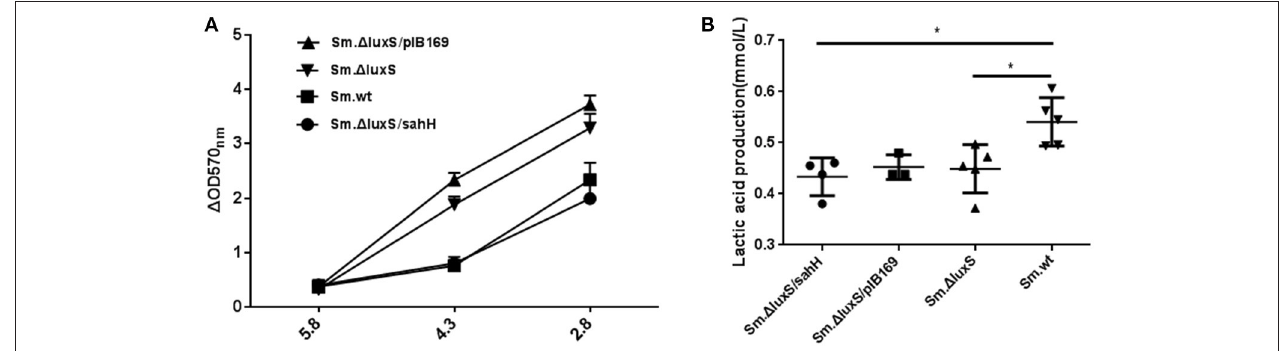
FIGURE 3 | Acid tolerance and lactic acid production of four bacterial strains in the presence of biofilms. (A) Acid tolerance of four bacterial strains. 1 OD570nm is the difference in optical density at 570nm between the experimental groups (pH 4.3 or pH 2.8) and reflects the acid-inhibition effect. The results are shown as mean ± SEM. (B) Variability in acid production in biofilms from the four strains. Lactic acid production was higher in the Sm. wt strain than in Sm. 1 luxS and Sm. 1 luxS / sahH strains. *Significant differences at P <